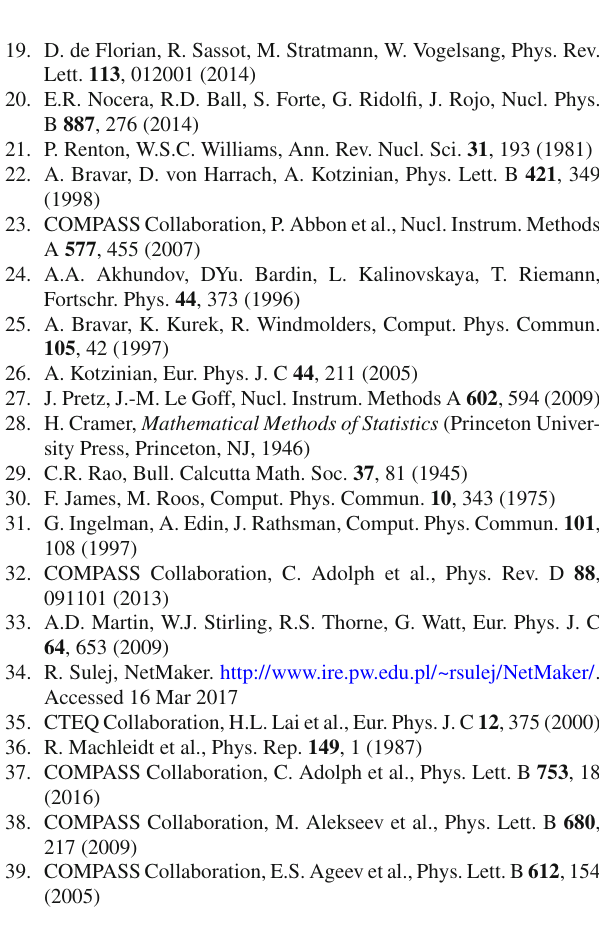
Table 3 The values for A h x Bj